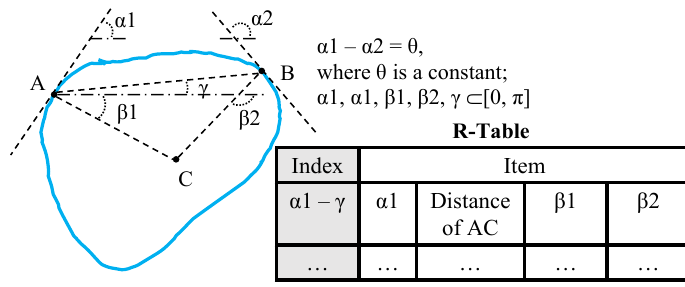
Figure 3. R-Table in the proposed RV-GHT.